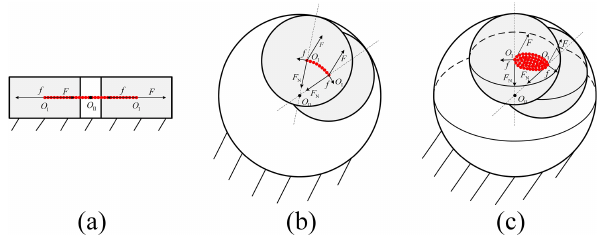
Figure 3. Static equilibrium positions of friction clearance joints.